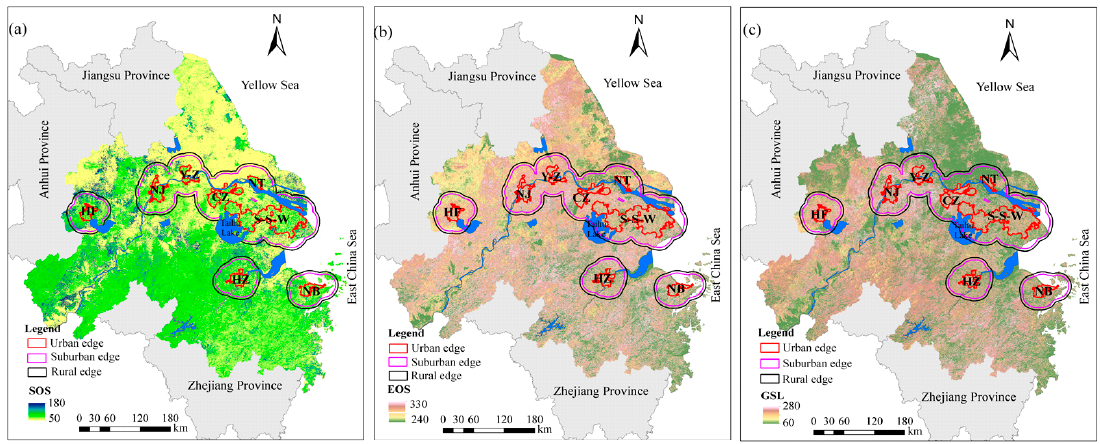
Figure 6. Three phenology indicators of start of season (SOS) ( a ), end of season (EOS) ( b ) and growth season length (GSL) ( c ), an example from 2015.